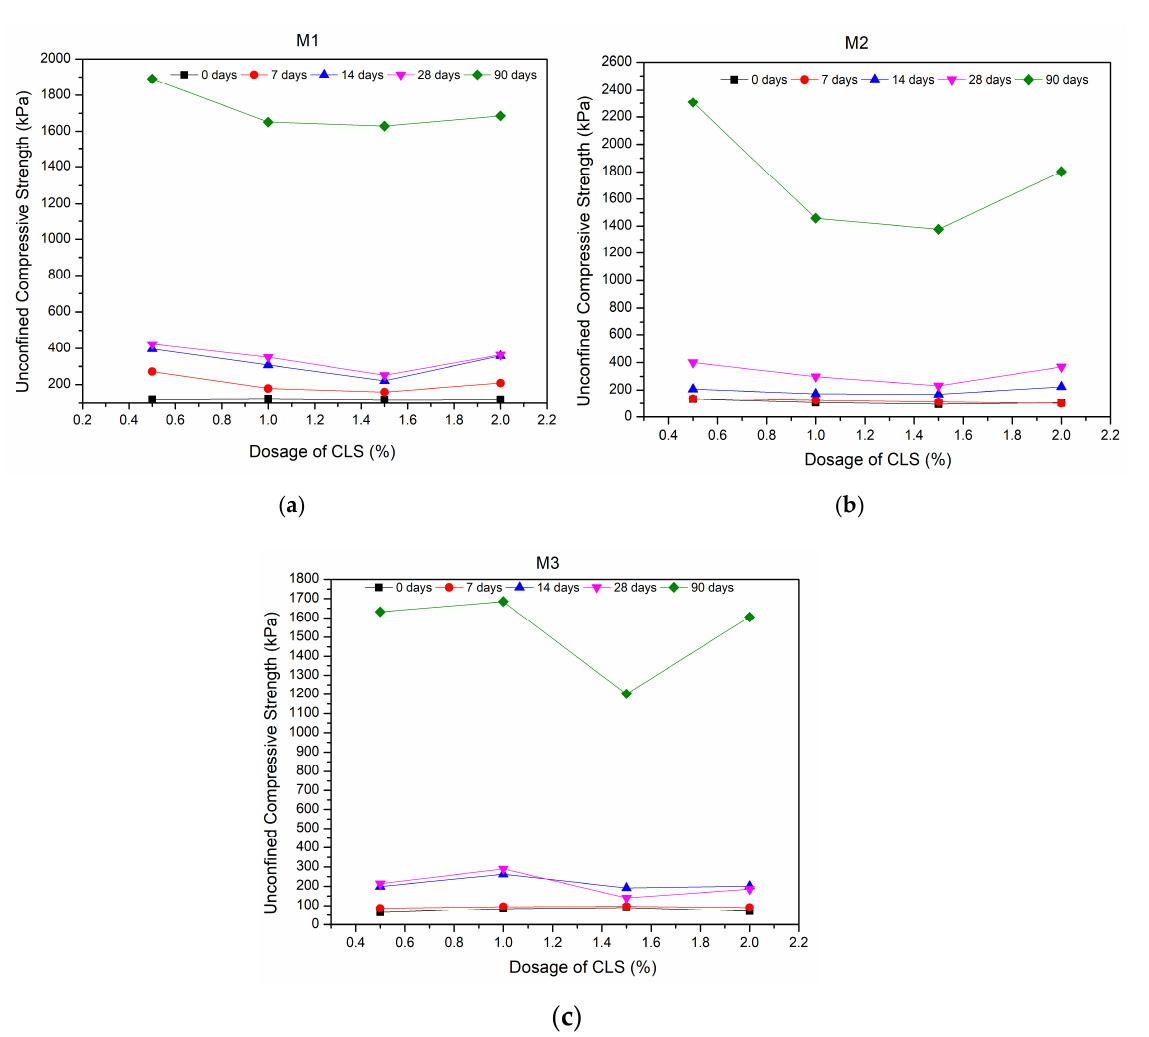
Figure 5. Detailed interaction mechanism involved with CLS. ( a ) CLS intact with clay particle ( b ) Adsorption of CLS over clay particle ( c ) Polymer chain formation ( d ) Basal bonding ( e ) Peripheral bonding. The treated soils were subjected to a gradual compressive load that fails by produc- ing a distant failure pattern [47]. Figure 6 describes the different failure patterns of the binary blended clay at varying dosages of GS. Samples mixed with 30% GS failed under lateral bulging. For 40% GS, the sample failed by producing a small network-type pattern along the vertical axis. For 50% GS, the samples make visible network type patterns due to comparatively higher coarser fractions’ presence.